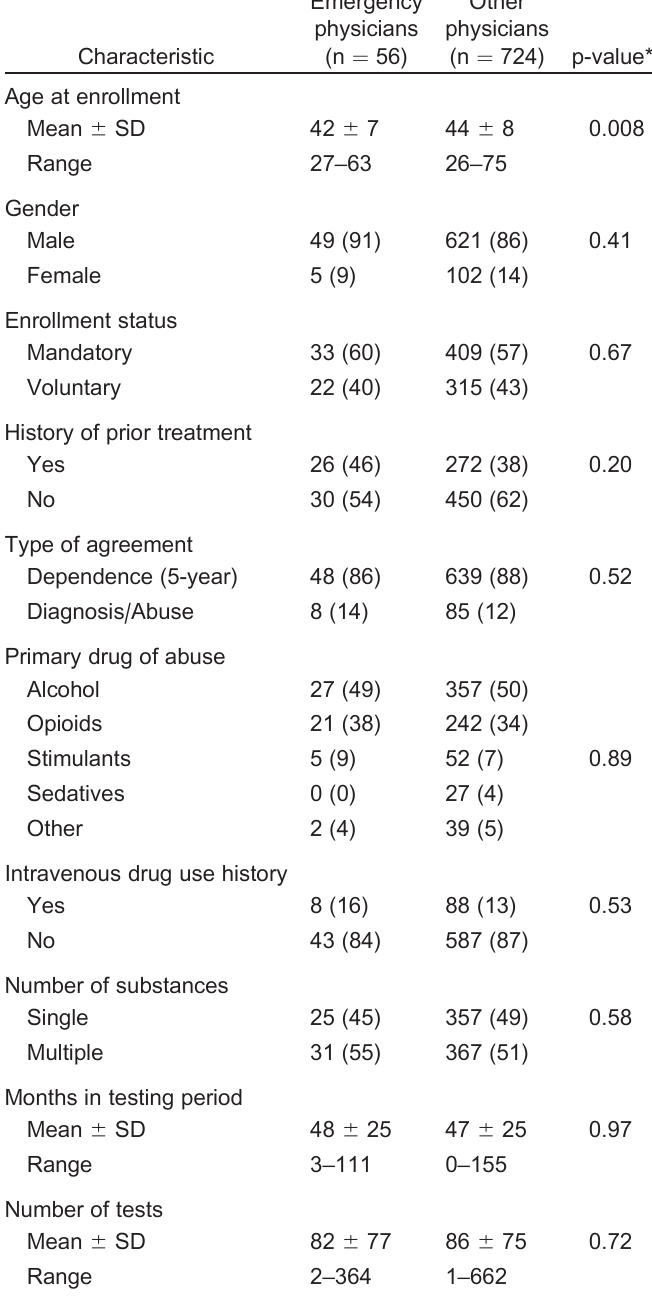
Table 1. Characteristics of emergency physicians and other physicians participating in state physician health programs for substance use disorders. *